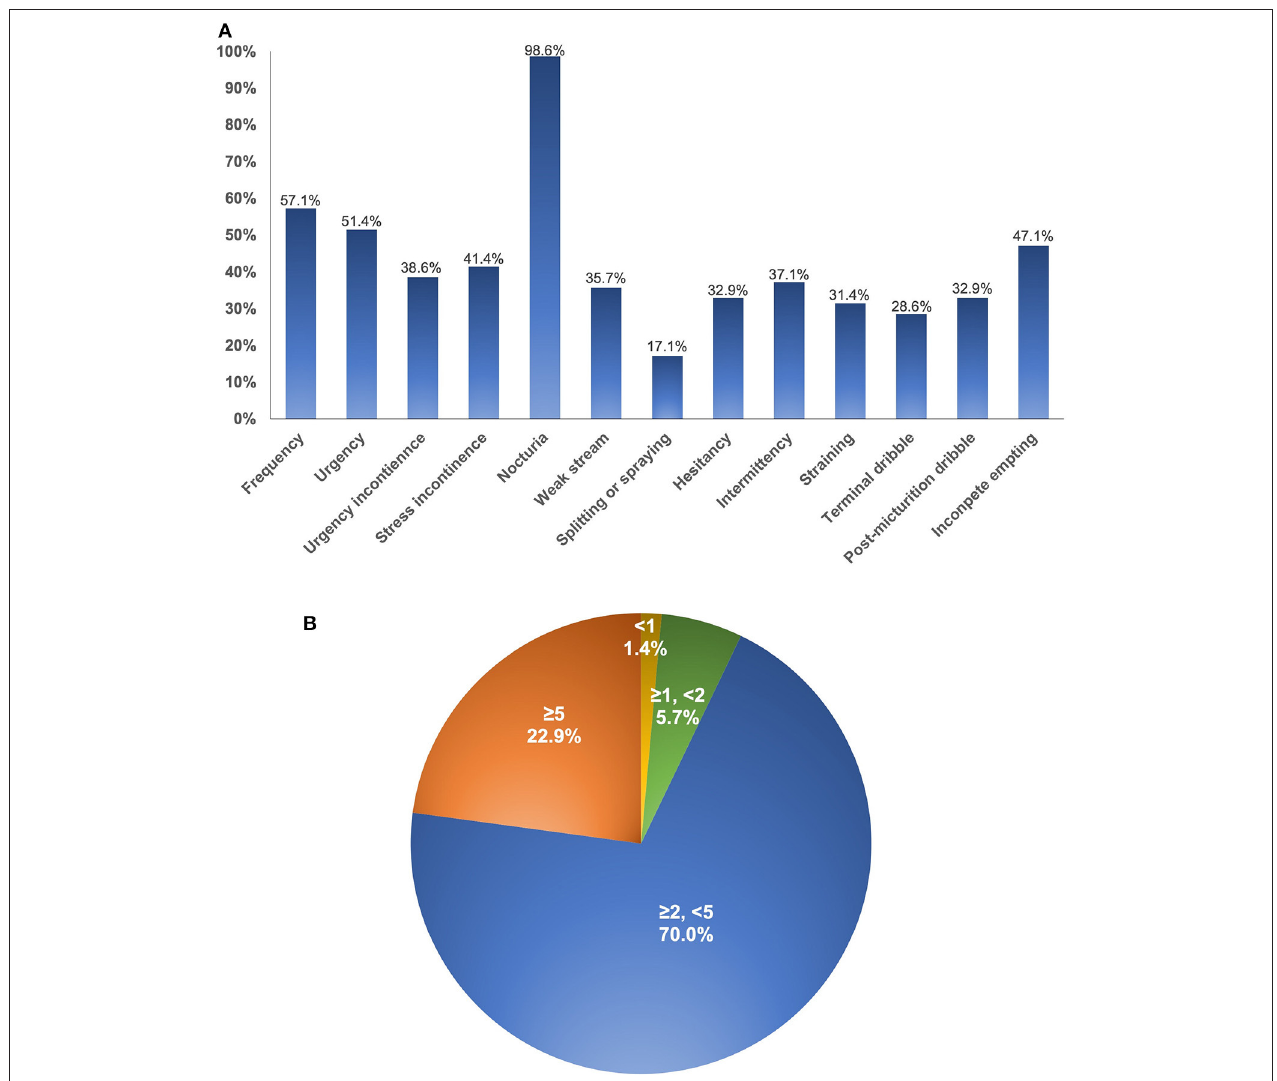
FIGURE 1 | The incidence of each lower urinary tract symptom subtype (A) and the distribution of nocturnal episodes (B) . Nocturia is defined as wake up at least 1 time to void during night-time